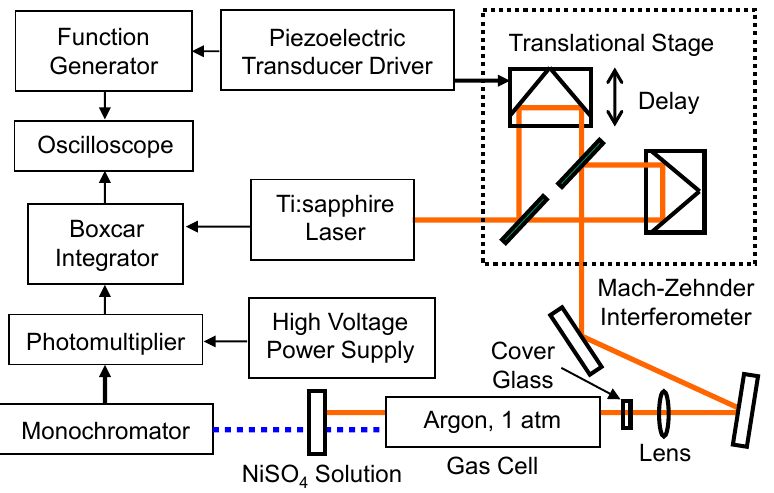
Figure 1. Experimental apparatus for third harmonic generation-fringe-resolved autocorrelator (THG-FRAC). The orange (solid) and blue (broken) lines show the fundamental and THG beams, respectively.